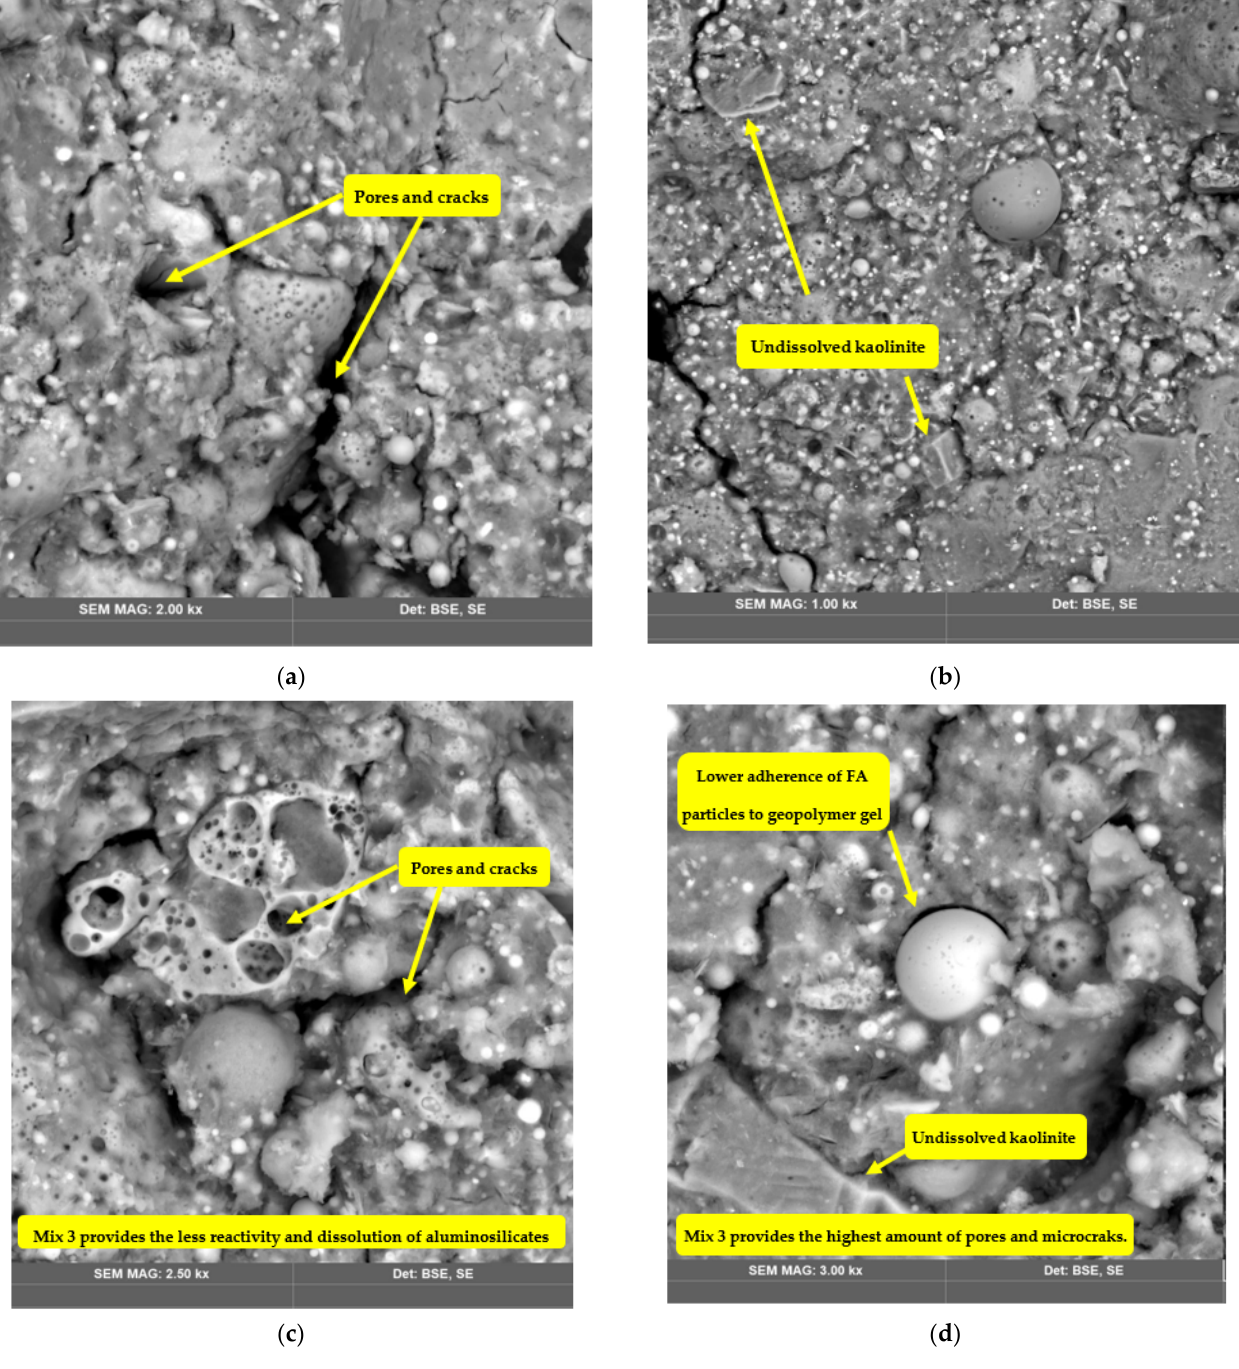
Figure 7. SEM images of Mix 3. The images on the left ( a , c ) were taken after 3 days of curing; the images on the right ( b , d ) were taken after 28 days of curing.